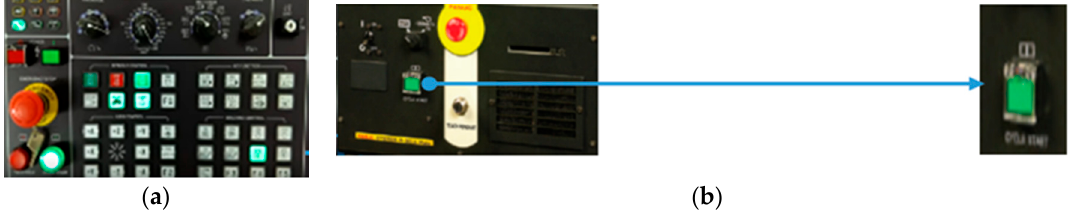
Figure 6. ( a ) Computer-numerically controlled (CNC) milling control panel; ( b ) Controller switch. Appl. Sci. 2018 , 8 , x FOR PEER REVIEW